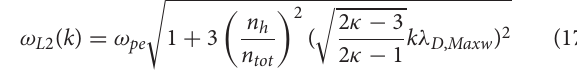
Frontiers in Astronomy and Space Sciences |